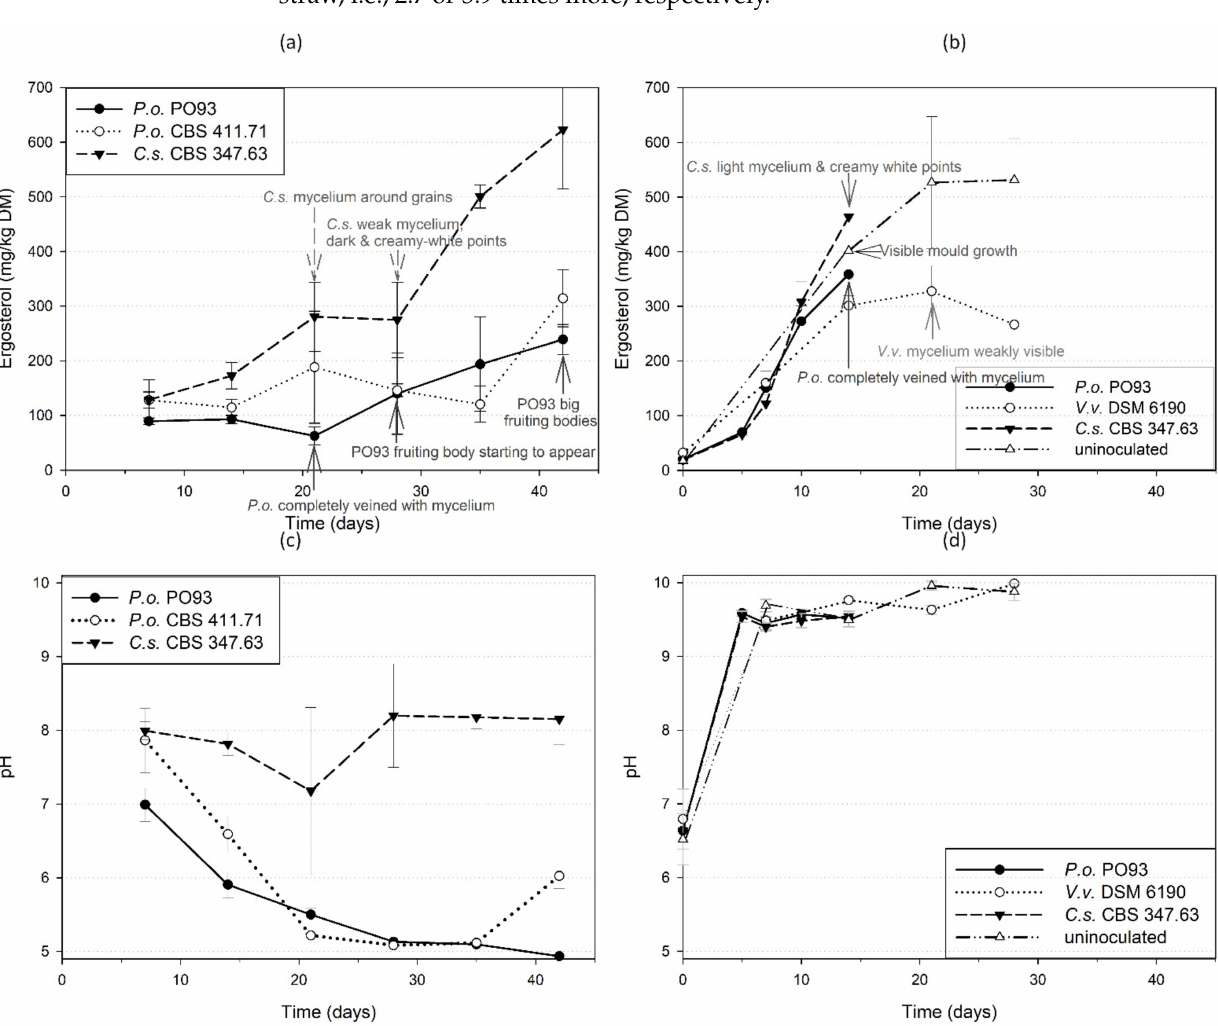
Figure 2. Ergosterol content and pH development in the straw treated with different fungi up to 42 d: ergosterol in ( a ) drained, ( b ) remoistened straw; pH in ( c ) drained, ( d ) remoistened straw. The text attached to the arrows describes the visual appearance and development of the fungi in the straw at the respective time. P.o. — Pleurotus ostreatus ; C.s. — Ceriporiopsis subvermispora ; V.v. — Volvariella volvacea . Error bars indicate the standard deviation